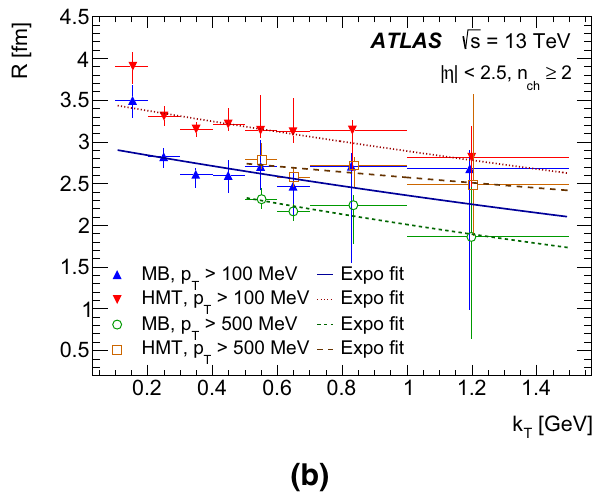
√ s = 13 TeV for the minimum-bias (MB) and high-multiplicity at track (HMT) events. The uncertainties represent the sum in quadrature of the statistical and systematic contributions. The curves represent the exponential fits to λ( k T ) and R ( k T )